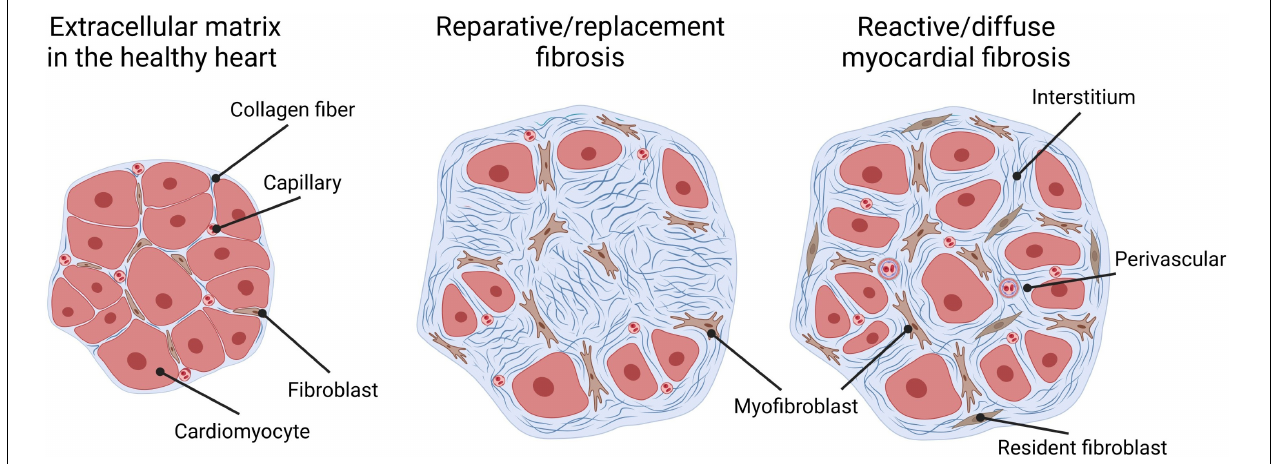
FIGURE 1 | Types of cardiac fibrosis. The extracellular matrix in the healthy heart (left) is a three-dimensional network of collagen fibers that embeds cardiac cells such as cardiomyocytes, capillaries, and fibroblasts. “Replacement/reparative fibrosis” (middle) is visible as a collagen-based scar that is formed during a healing process and replaces dying cardiomyocytes after ischemic insults. “Reactive/diffuse myocardial fibrosis” (right) accompanies heart failure due to pressure overload and manifests as diffuse deposition of cross-linked collagens in interstitial and perivascular areas. Both patterns of fibrous deposits can be observed in patients with heart failure with reactive fibrosis, due to the formation of micro scars related to smaller foci of replacement fibrosis that are reflective of a loss of small numbers of